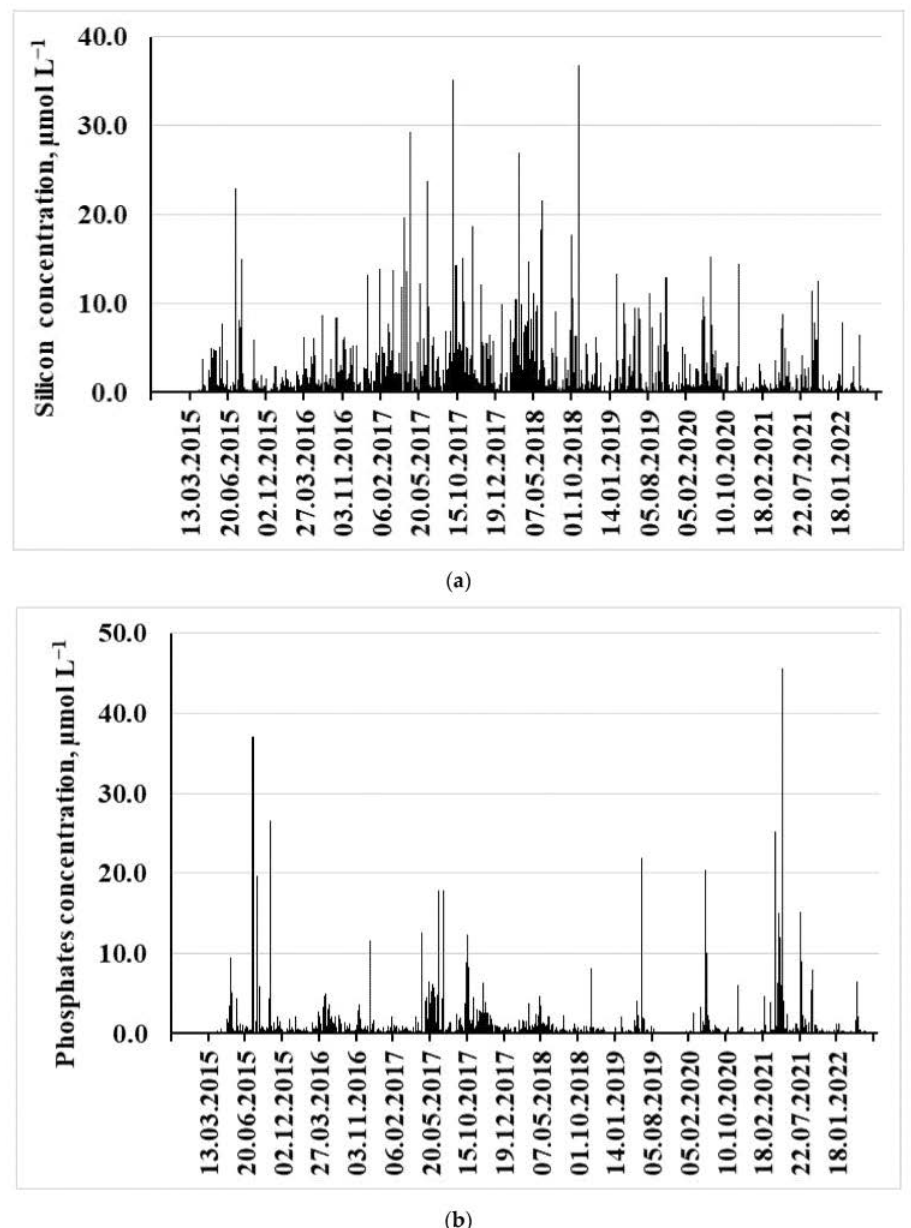
Figure 5. Time series plots of silicon ( a ) and phosphates ( b ) concentrations in the atmospheric precipitations from the open